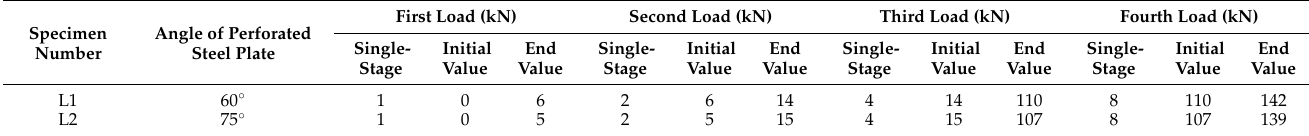
Figure 5. Schematic diagram of loading scheme. Table 2. Load segmented and hierarchical